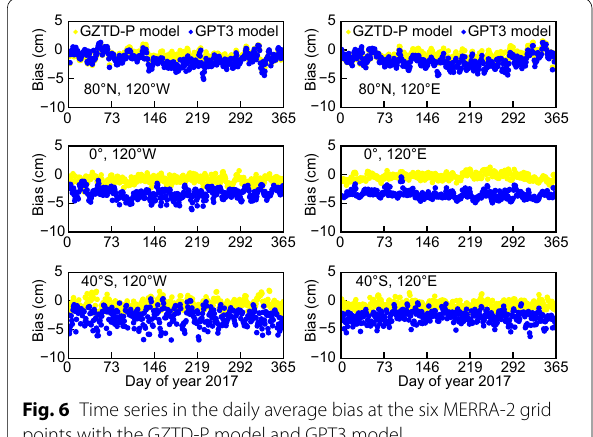
Fig. 6 Time series in the daily average bias at the six MERRA-2 grid points with the GZTD-P model and GPT3 model